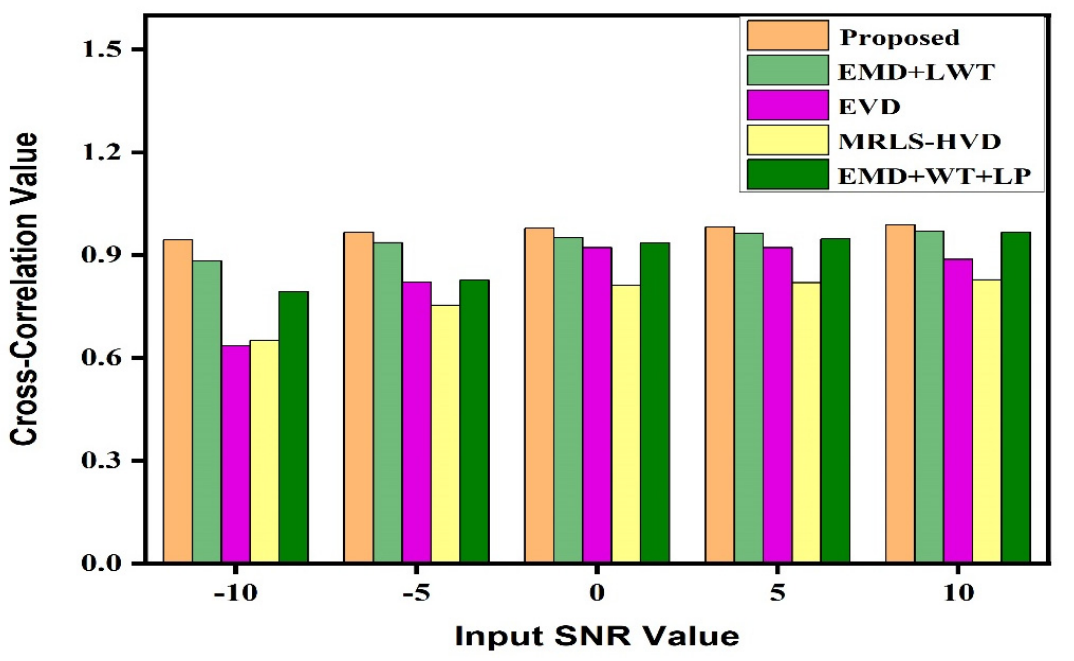
Figure 12. Comparison between the proposed method and various other methods in terms of average cross-correlation values between the clean input and denoised output signals in presence of 50 Hz PLI and baseline wander.